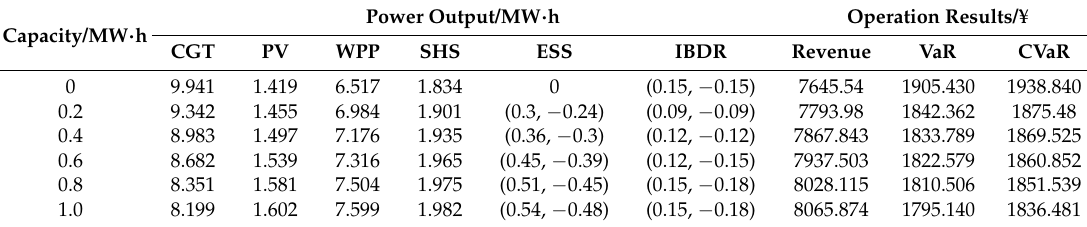
Table 5. Scheduling results of VPP operation under different ESS Capacities (typical winter day).